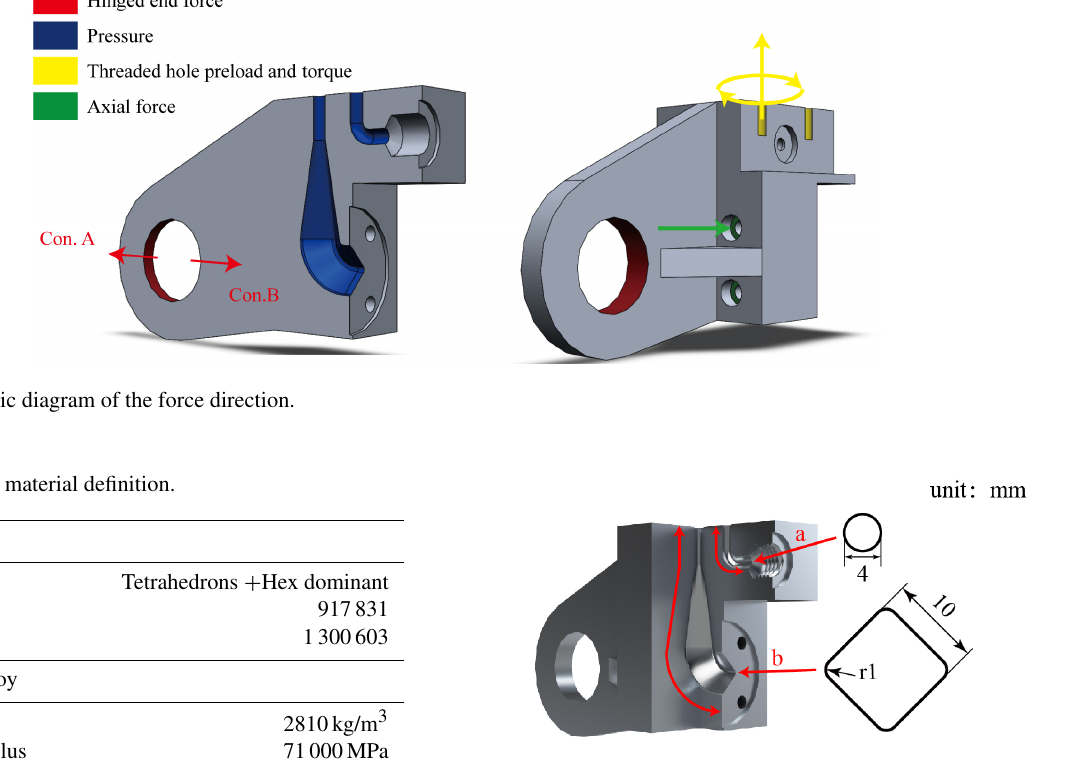
Figure 7. Channel design.